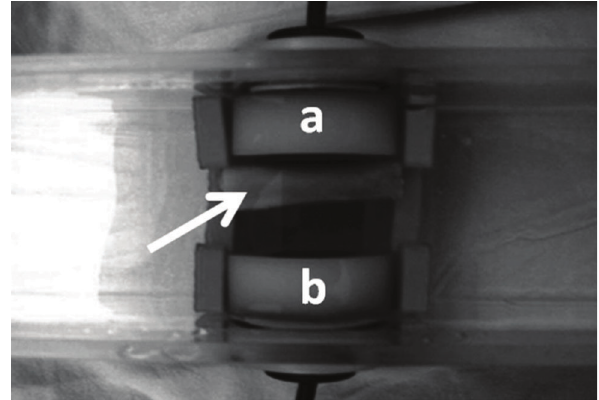
Figure 3 - The diaphyseal segment inside the acoustic tank (arrow) positioned between the transmitting (a) and receiving (b) ultrasound transducers.